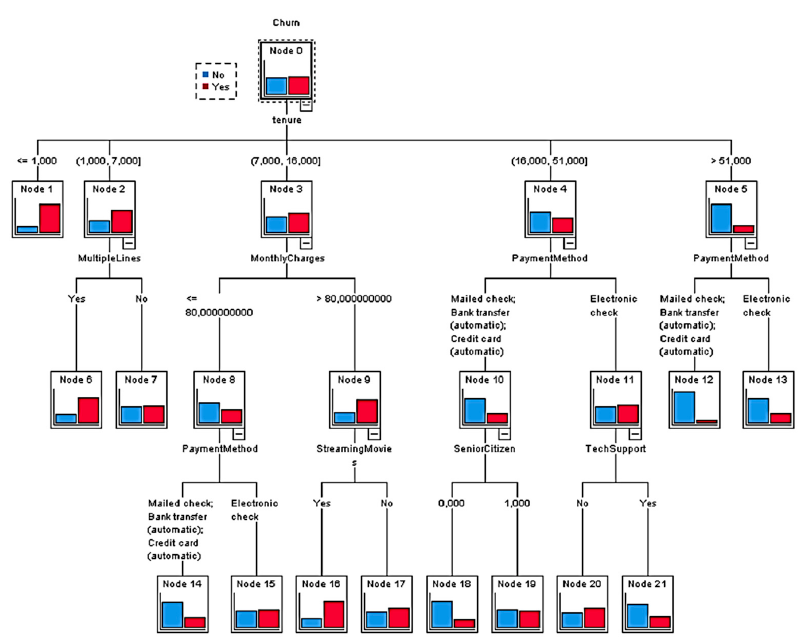
Figure 5. CHAID decision trees for Cluster 3. Source: authors’ work,